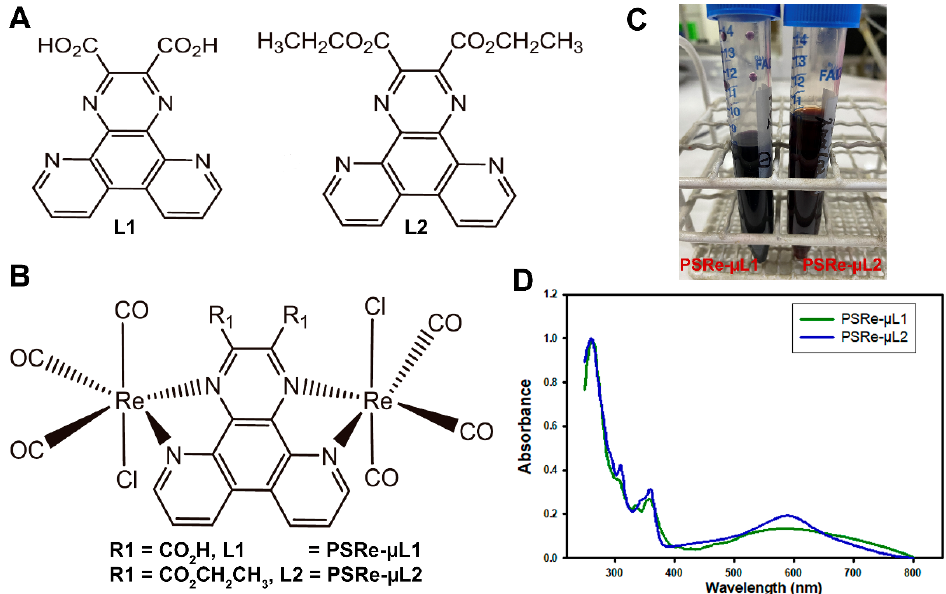
Figure 1. Chemical structure of the Re(I) bimetallic photosensitizer compounds and their L ligands and absorption spectra. The chemical structure of Re(I) complexes show the L1 and L2 ligands ( A ) and the (Re(CO) 3 Cl) 2 µ-N^N, whose replacement of R 1 results in the PSRe-µL1 and PSRe-µL2 compounds ( B ). Macroscopic appearance of PSRe-µL1 and PSRe-µL2 compounds concentrated in solution at 2 mg/mL ( C ). The absorption spectra for the PSRe-µL1 and PSRe-µL2 compounds in acetonitrile solution ( D ). Table 1. Photophysical and electrochemical evaluation of photosensitizers. Compounds